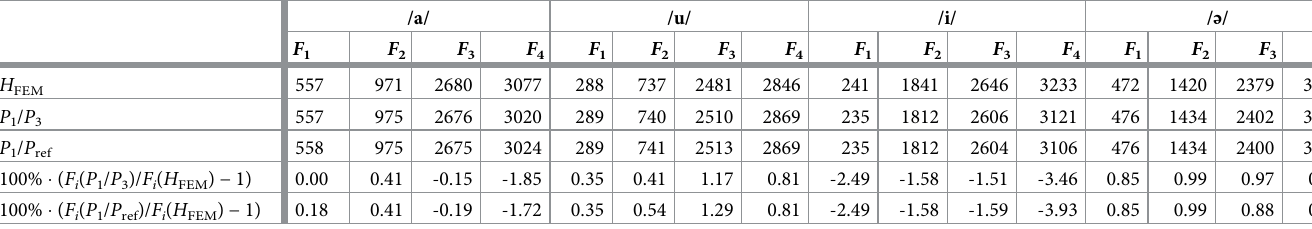
Fig 6. Calculated measures. Transfer functions P 1 / P 3 , P 1 / P ref , and the simulated transfer functions H FEM for the models /a/ (A), /u/ (B), /i/ (C) and /e/ (D). https://doi.org/10.1371/journal.pone.0193708.g006 In addition, Tables 2 & 3 show the bandwidths and amplitudes of the resonances of all models and their deviation from the finite element models. The average bandwidth and ampli- tude deviation between P / P and H are 25.3 Hz and 4.1 dB, and between P / P and H 1 3 1 FEM ref FEM these values are 31.6 Hz and 5.1 dB. Also here, there are no big differences between the two measured volume velocity transfer functions. It should be kept in mind that these values strongly depend on the selected wall impedance Z . It is quite possible to optimize the values wall in such a way that the deviations of amplitudes and bandwidths are minimized. However, this would go beyond the scope of this work. Table 1. Formant frequencies in Hz of the simulated and measured transfer functions and their relative deviations in